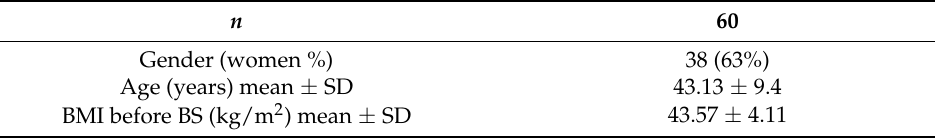
Table 2. The baseline characteristics of the patients included in the study.